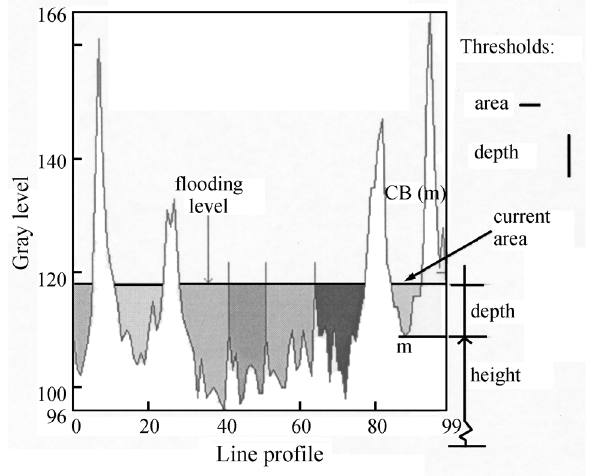
Figure 5. Attributes of a catchment basin.